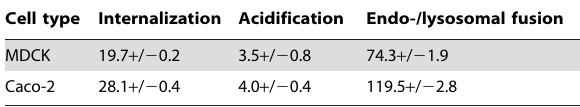
Table 1. Measured t 1/2 (minutes) of InlA-bead internalization, phagosomal acidification and phagosomal-endosomal/ lysosomal fusion in MDCK and Caco-2